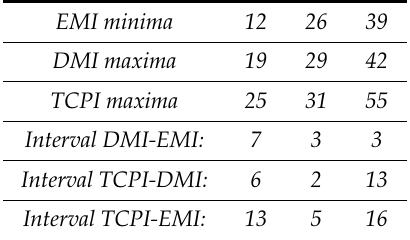
Table 11. Minima in the EMI (Figure 11) and the corresponding local maxima in the DMI followed by a dip in the TCPI.